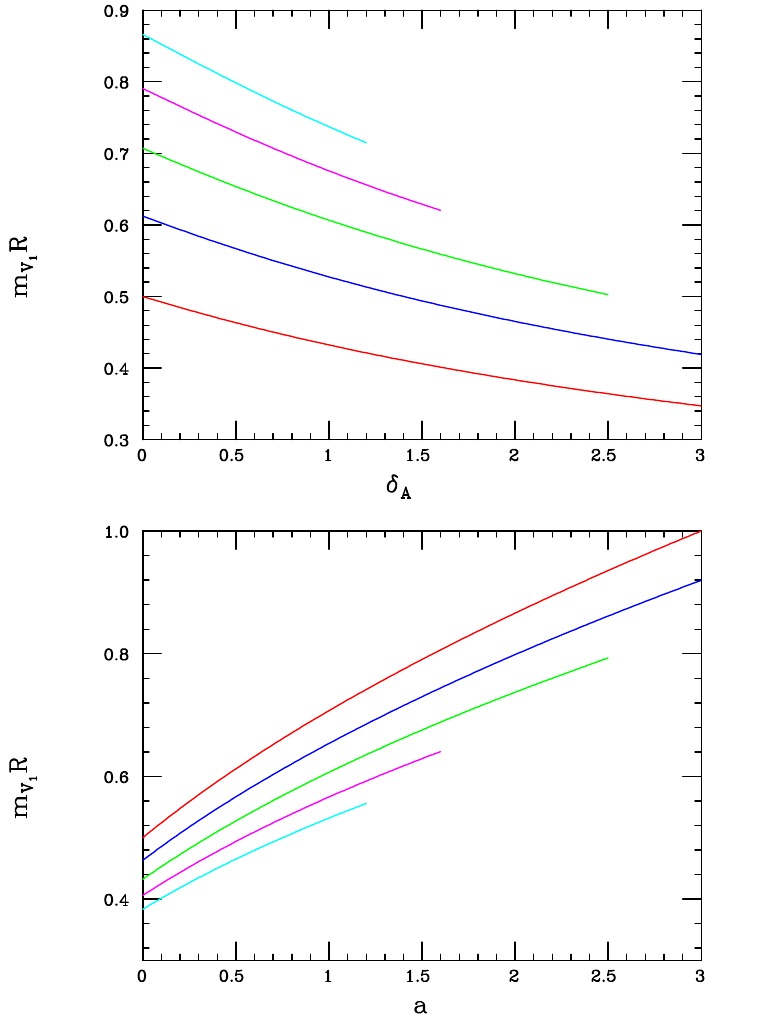
Figure 2 . (Top) Lightest gauge KK mass as a function of (cid:14) A for a = 0(0 : 5 ; 1 ; 1 : 5 ; 2) corresponding to the red (blue, green, magenta, cyan) curve. (Bottom) Same as above but with the roles of a and (cid:14) A interchanged. Note that that the curves terminate due to the a max bound as discussed in the